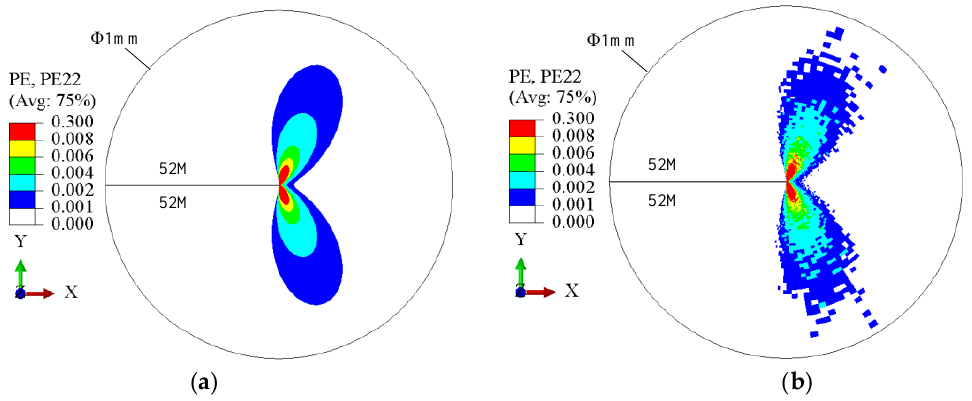
Figure 9. Normal plastic strain at the tip of crack 1: ( a ) homogeneous; ( b ) inhomogeneous.